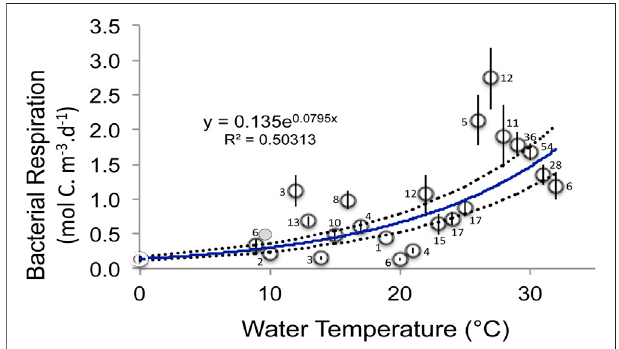
FIGURE 3 | Global freshwater bacterial respiration as a function of each whole degree of water temperature ( (cid:1) x μ ± SE; n = number on each data point) Theaverage( n =273).Percentileerrorfordatawas20%(shownasthedotted lines). Additional Arctic bacterial respiration data (Great Bear Lake) ( n = 85) is shown as the shaded circle, was overlaid on the rest of the global respiration data. The additional data fi t well with the relationship between bacterial respiration and water